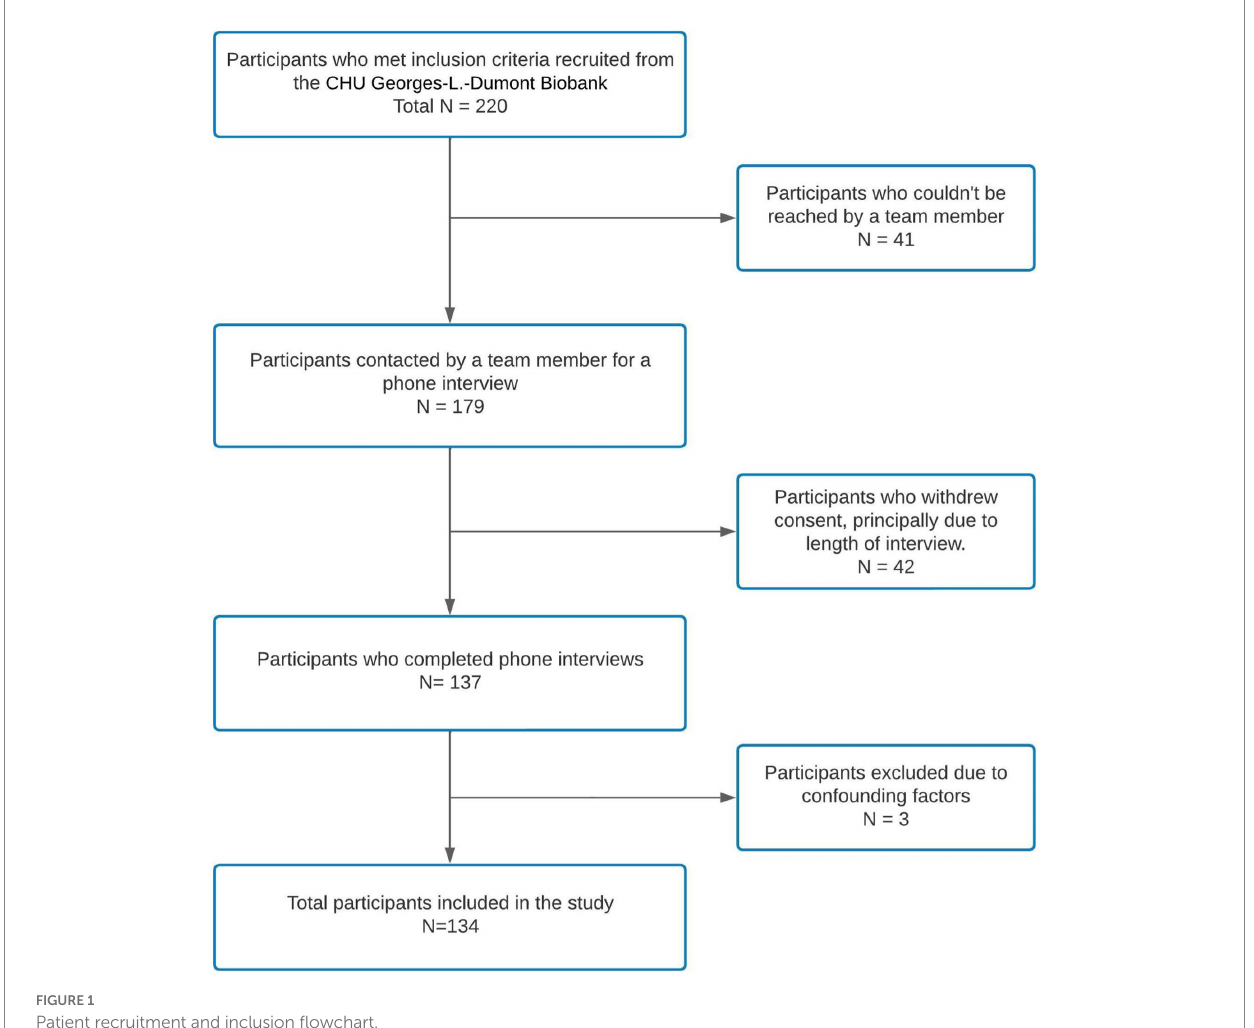
FIGURE 1 Patient recruitment and inclusion flowchart.